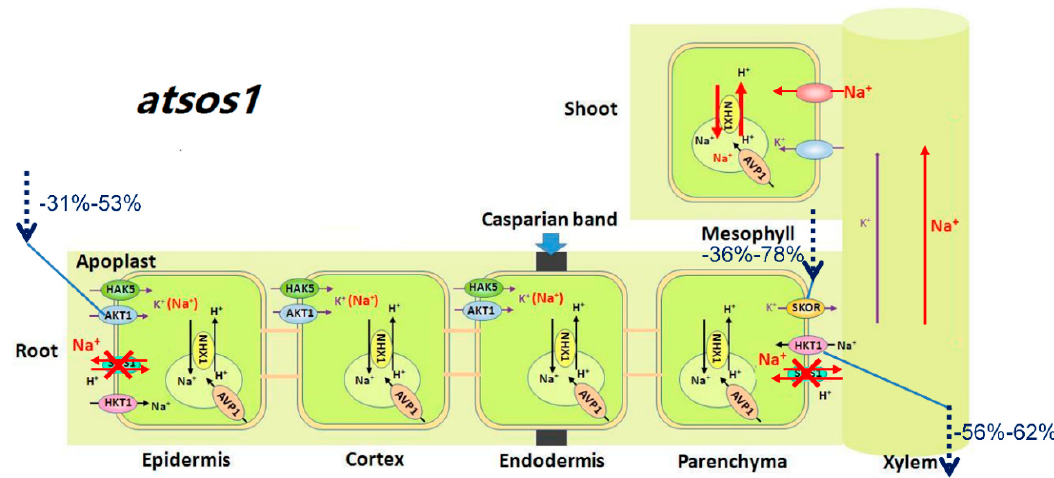
Figure 6. Schematic model for the function of AtHKT1;1 and AtSOS1 in regulating K + and Na + transport in atsos1 of A. thaliana under saline conditions. For the plants growing in 25 mM NaCl, the mutation of AtSOS1 not only interdicted Na + loading toward shoots but also prevented Na + excretion from the roots to the soil. Compared with WT, loss-of-function of AtSOS1 induced a 56–62% (6–24 h) decrease in transcripts of AtHKT1;1 , a 36–78% (6–24 h) decrease in transcripts of AtSKOR , and a 31–53% (6–24 h) decrease in transcripts of AtAKT1 in the roots. Consequently, a mass of Na + was accumulated in the roots, whereas K + uptake and transportation was restrained.